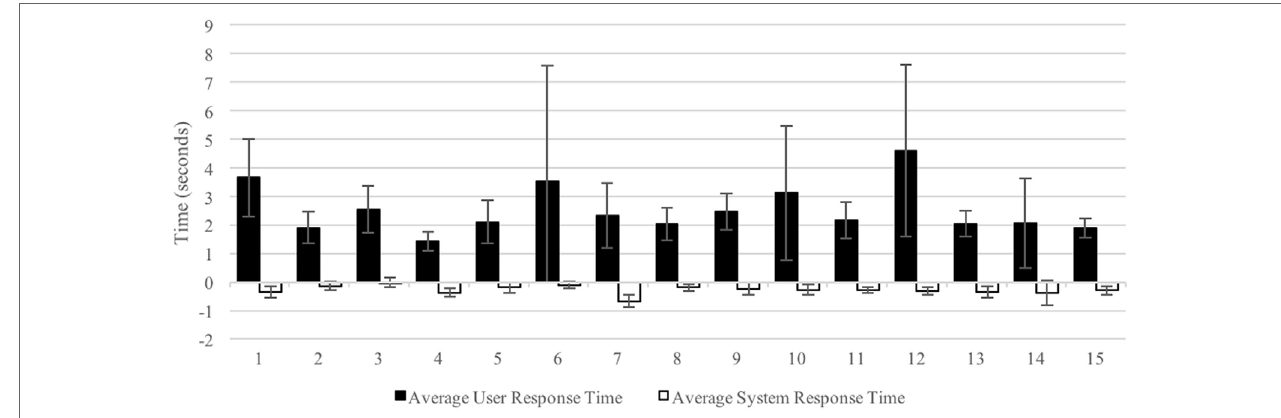
FigUre 7 | Average user and system response time across